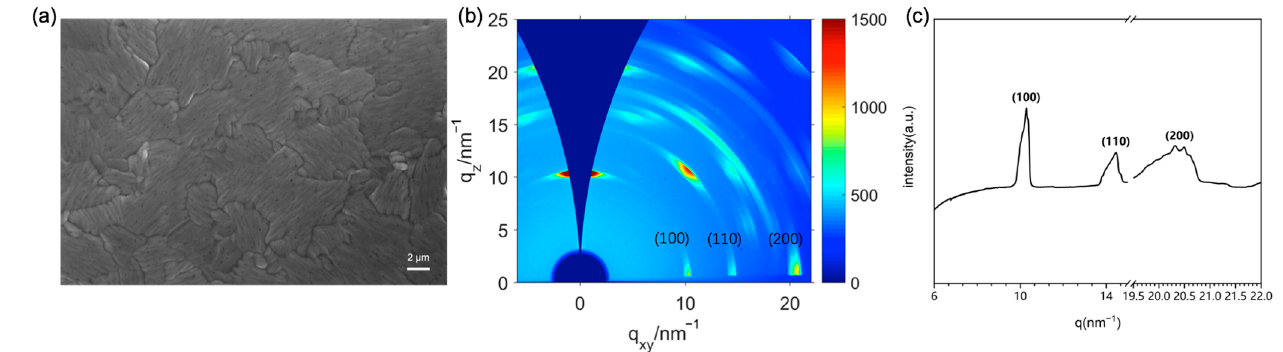
Figure 1. ( a ) The SEM image; ( b ) 2D GIXRD pattern and ( c ) 1D GIXRD spectra derived from ( b ). To investigate the electronic structure at the CuPc/CsPbI 2 Br interface, XPS measure- ments were conducted and the core level spectra of the elements from CsPbI 2 Br film with different CuPc thicknesses are reported in Figure 2a–d. The binding energies of Cs 3 d 5/2 , Pb 4 f 7/2 , I 3 d 5/2 and Br 3 d 5/2 peaks for pristine CsPbI 2 Br film are located at 724.99 eV, 138.61 eV, 619.41 eV and 68.74 eV, respectively. Upon the deposition of CuPc films, the bind-